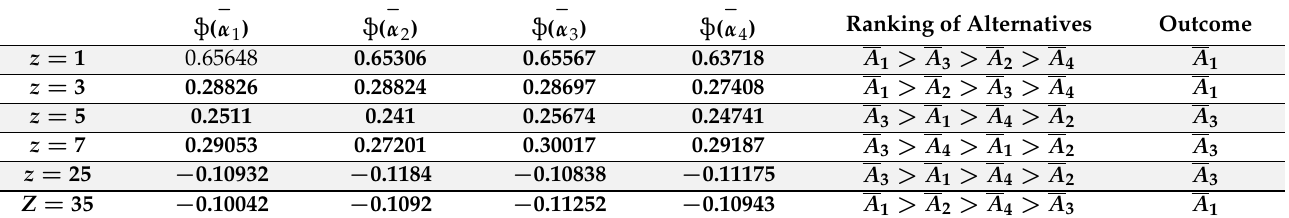
Table 21. Influence of variable